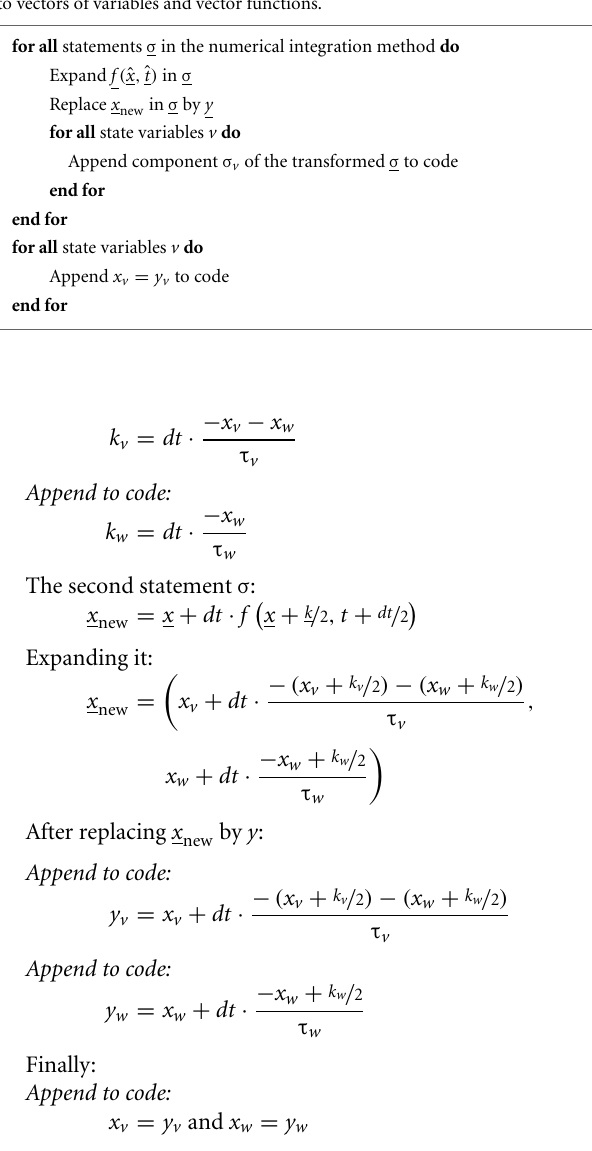
Algorithm 1 | Combining model equations and numerical integration